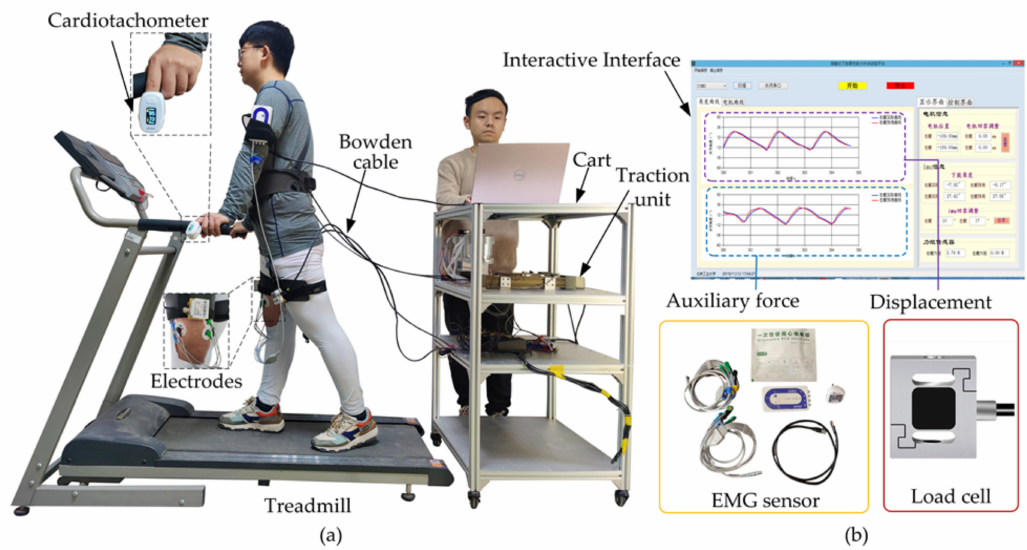
Figure 7. Experimental platform of the H-Suit. ( a ) The subjects walked on the treadmill at three different speeds. ( b ) The data of EMG, auxiliary forces and displacements are measured and depicted in the visual